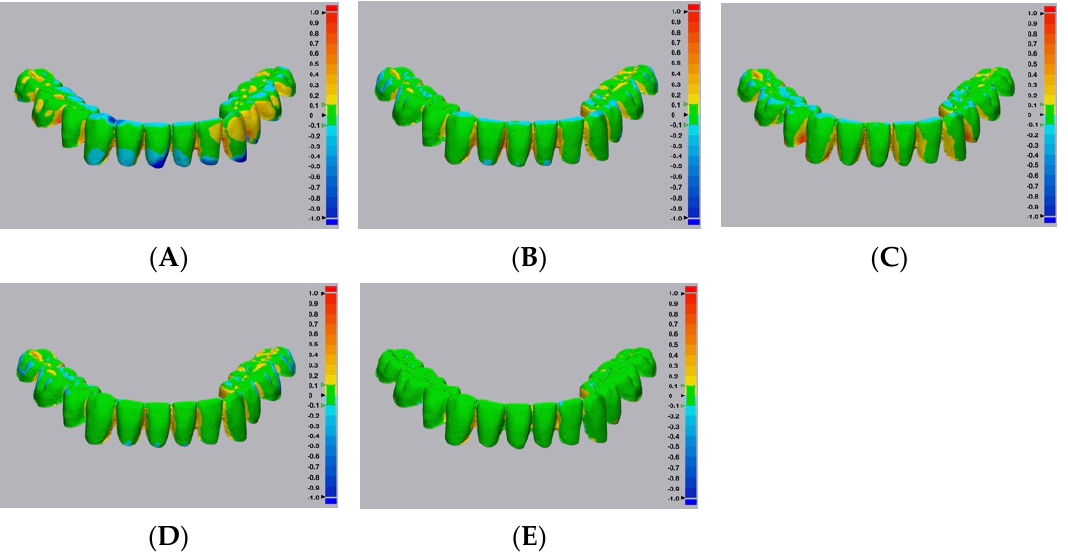
Figure 4. Representative surface matching color maps from the five study groups, across dentition portions. ( A ) Group 1—conventional technique. ( B ) Digital—CBCT—DLP 3D printer. ( C ) Digital— CBCT—SLA 3D printer. ( D ) Digital—Laboratory Scanner—DLP 3D printer. ( E ) Digital—Laboratory Scanner—SLA 3D printer.